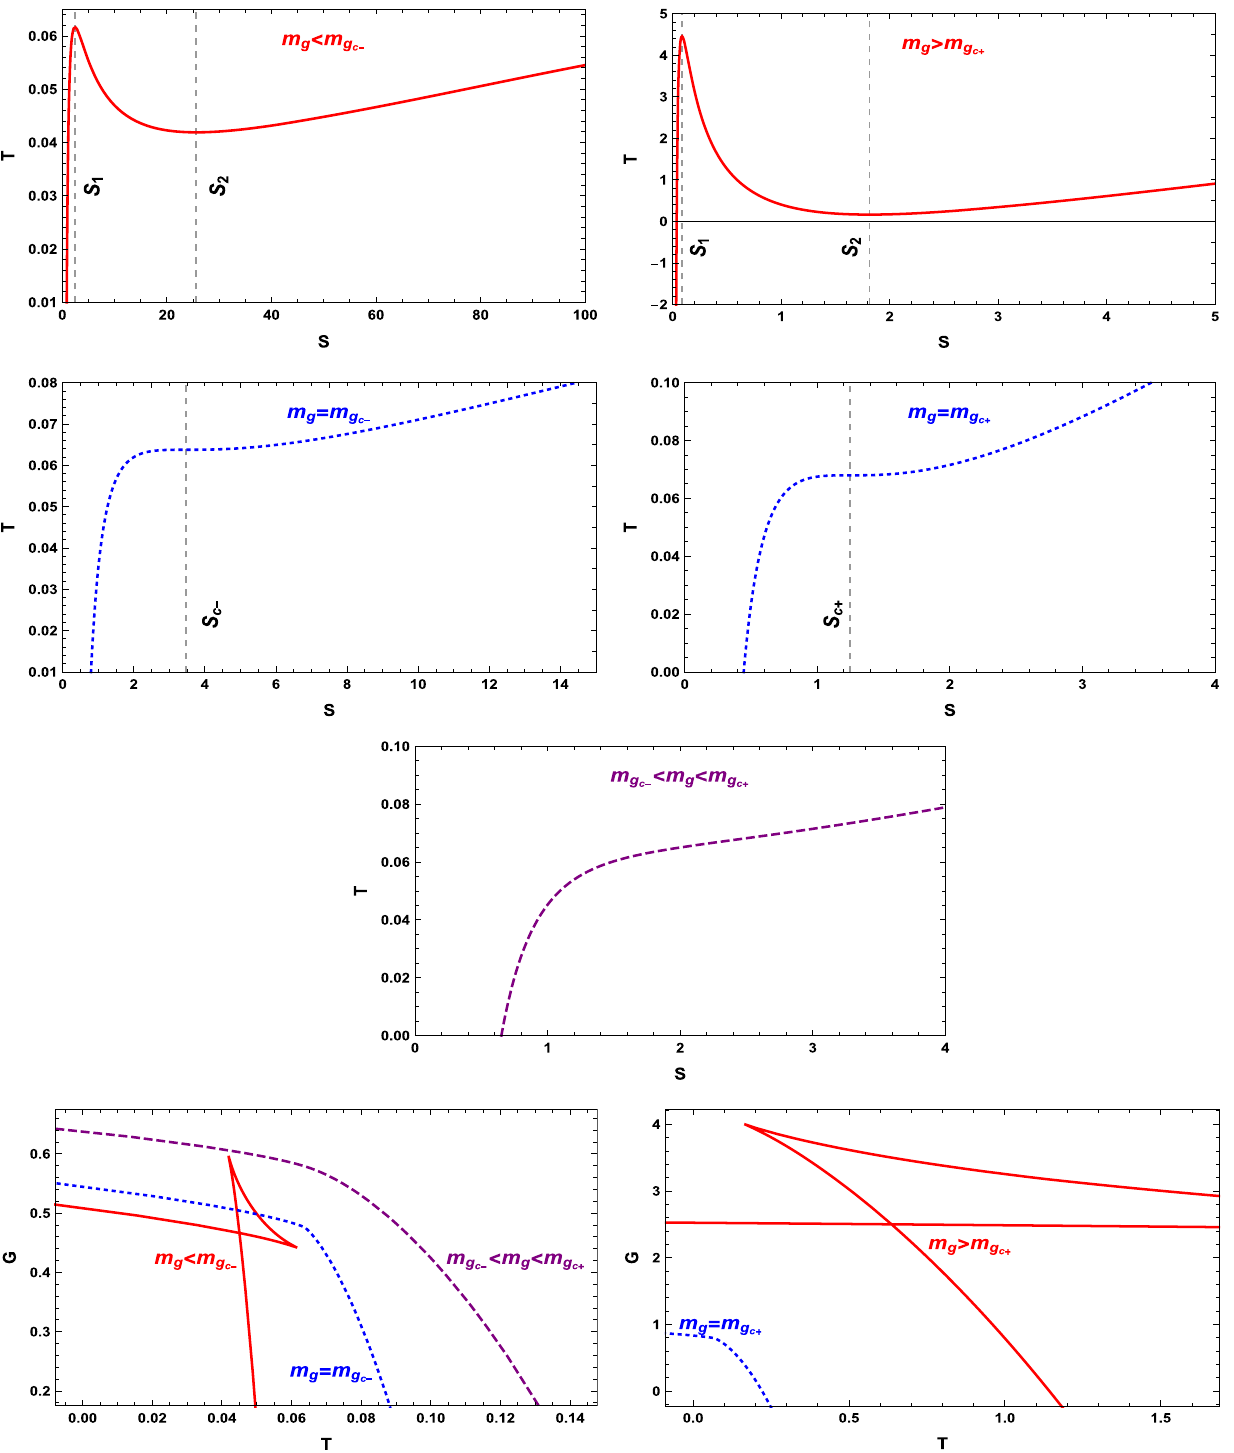
Fig. 5 Canonical ensemble: the charged BH temperature as a function of the entropy. The two last panels shows the Gibbs free energy as function of Hawking temperature, with parameter set Q = 0 . 5 , c = 1 , α = 1 and β =